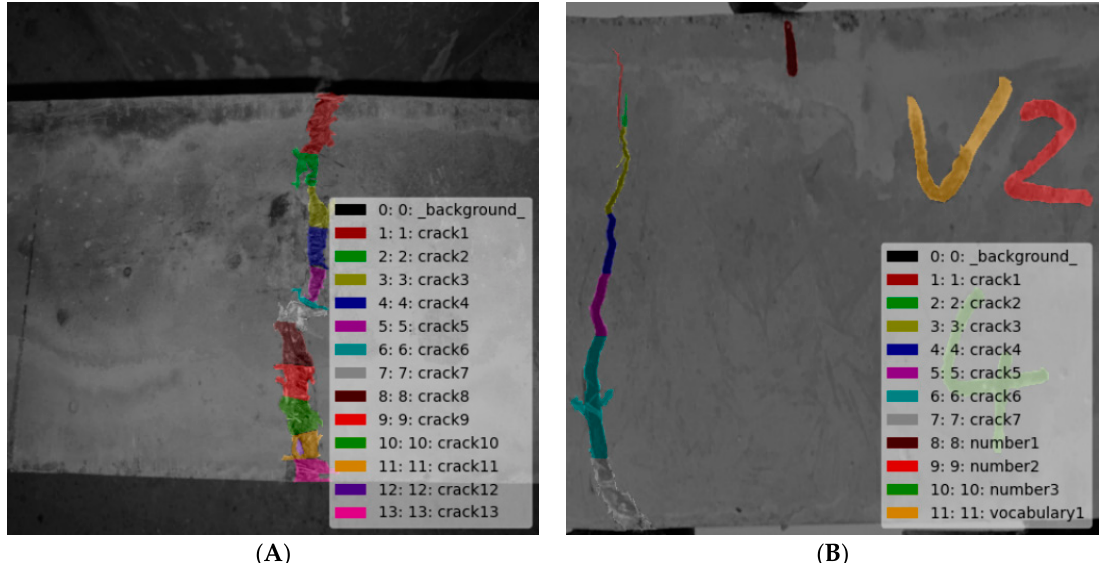
Figure 9. Original data label sample. ( A ) Only crack image; ( B ) three classes